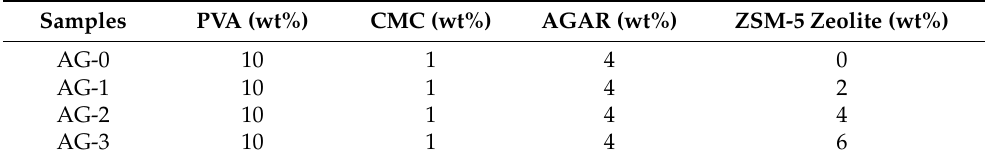
Table 2. The composition of the